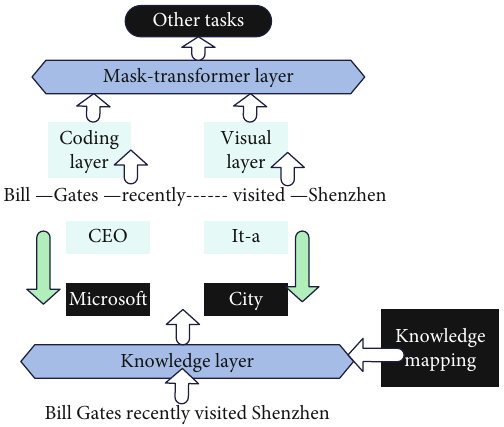
Figure 8: K -BERT model